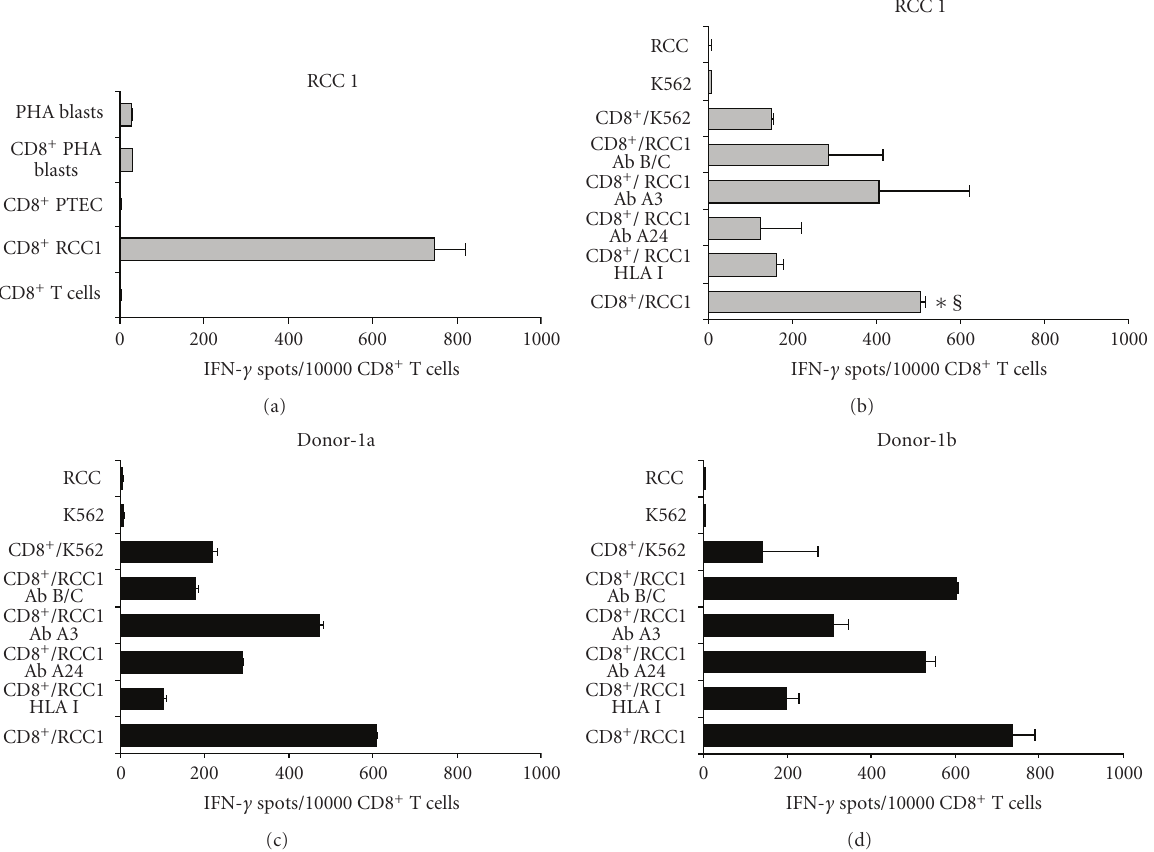
Figure 2: IFN- γ ELISPOT analyses of RCC-specific CD8 + T cell responses after MLTC. RCC1 CD8 + T cells stimulated by MLTC were tested for their reactivity against HLA-matched target cells such as autologous RCC, PTEC, and PHA-activated PBMC, (a). In panels (b), (c), and (d), K562 cells served as targets. A paired t -test analysis was used to compare the frequencies of autologous responder-CD8 + T cells versus allogenic responder-CD8 + T cells generated from the patient’s sibling ( ∗ P < . 05) and unrelated donor ( § P < . 03), stimulated with RCC1 line. The HLA restriction of the anti-RCC T cell response was determined by addition of blocking mAbs specific for total HLA-class I, HLA-A24, HLA-A3, or HLA-B/-C alleles. Results represent the average ( ± SD) of triplicate wells and the presented data derive from 1 representative experiment of 5